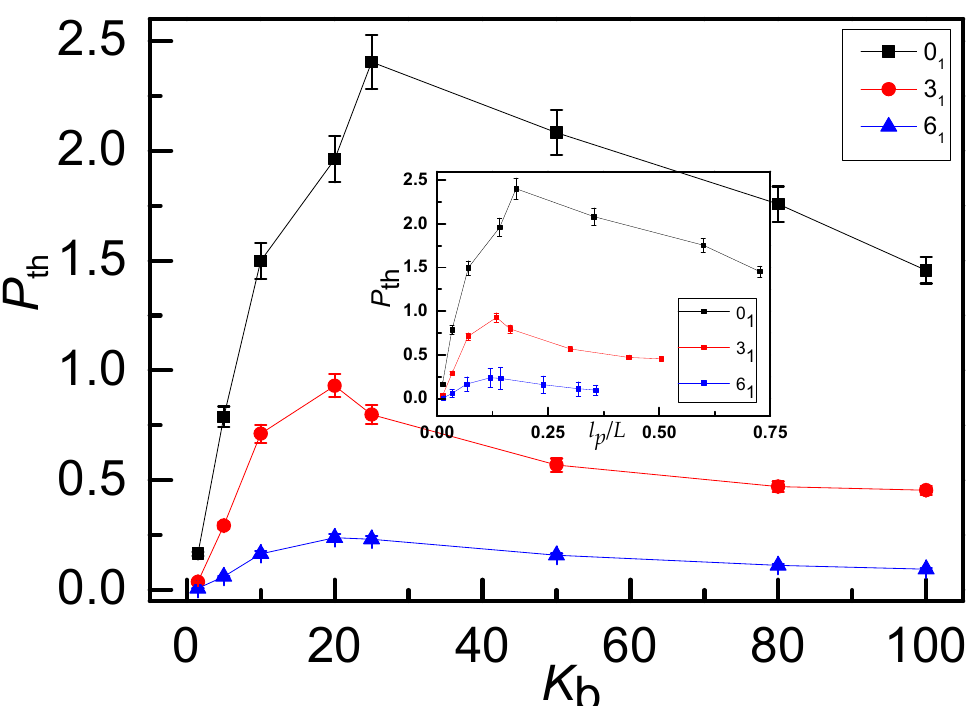
Figure 3. Average threading number P th shows a non-monotonous dependence on bending energy K b for 0 1 -knot, 3 1 -knot and 6 1 -knot ring polymers. The peak appears at the intermediate stiffness corresponding to the semi-flexible case. Inset: Average threading number P th as a function of l p /L , where l p denotes the persistence length and L is the contour length of the chain.